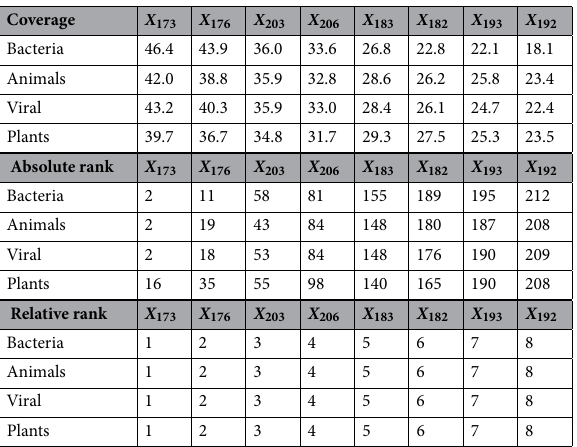
Table 1. Coverage (upper panel), absolute ranks (mid panel) and relative ranks (lower panel) for the equivalence class of 8 circular codes presented in Table 4. The universality of the results is clear if we consider the ranks within classes: for instance the coverage of code X 173 for bacteria is 46.4% (upper panel). It is not the highest coverage among the 216 codes, indeed it is the second (mid panel). However, it is always the highest within its class (lower panel). This universal behaviour holds for the whole set of 216 codes partitioned in 27 equivalence